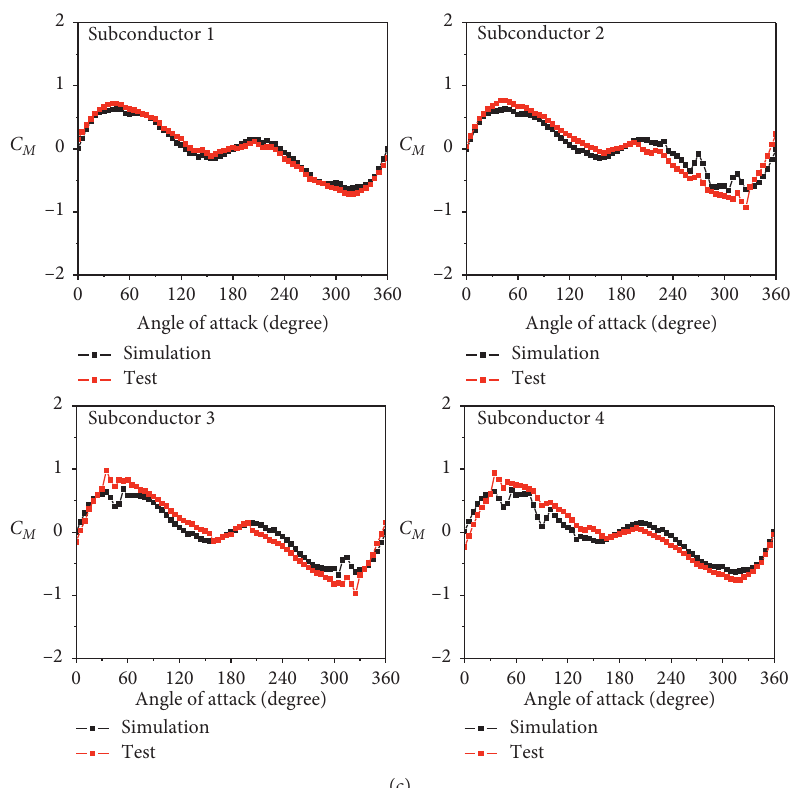
Figure 3: Aerodynamic coefficients of the iced quad bundle conductor varying with wind attack angle (wind velocity: 12m/s): (a) lift coefficients, (b) drag coefficients, and (c) moment